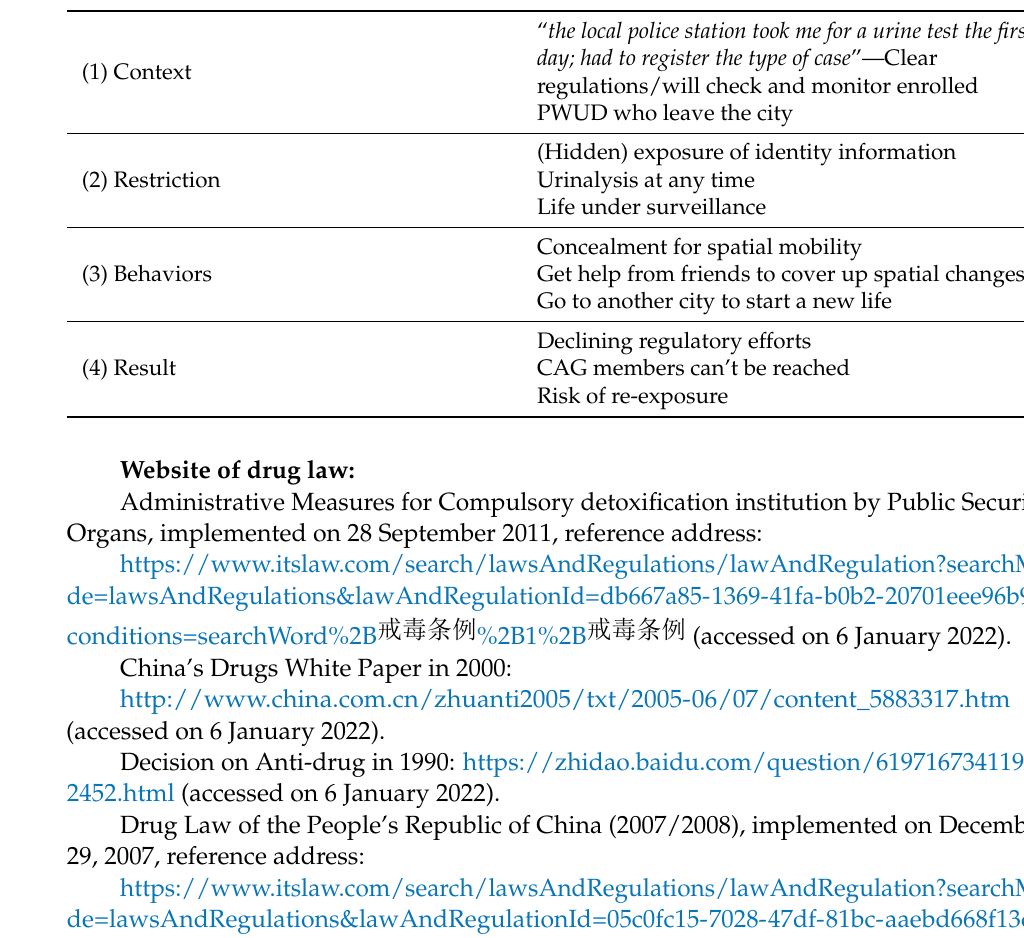
Table A3. Recoding by context and genera.